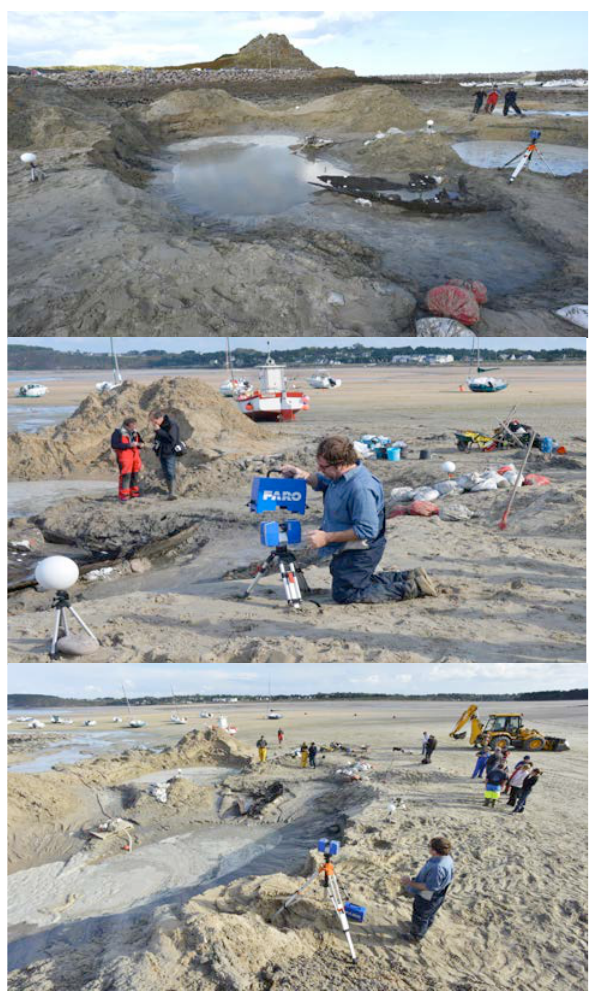
Figure 10. Wreck digitization with laser scanner (F.Osada/Drassm) Seven stations were performed in 62 minutes, between 3:13pm and 4:15pm. The seven positions of the laser scanner are presented in purple in Figure 11, and the positions of the four laser targets, in green.